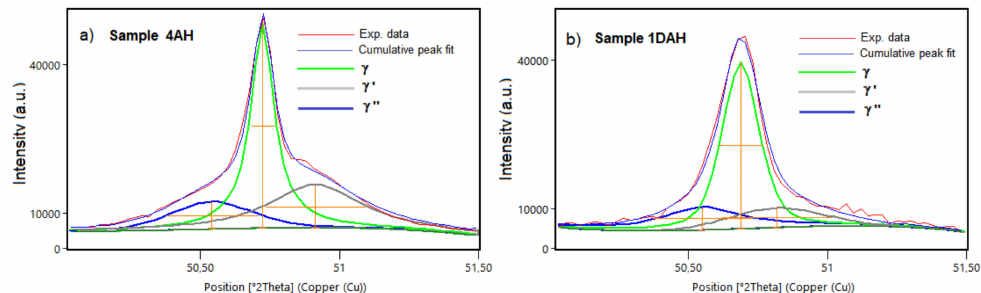
Figure 16. The fitting results of the peaks 200 for ( a ) 4AH sample and ( b ) 1DAH